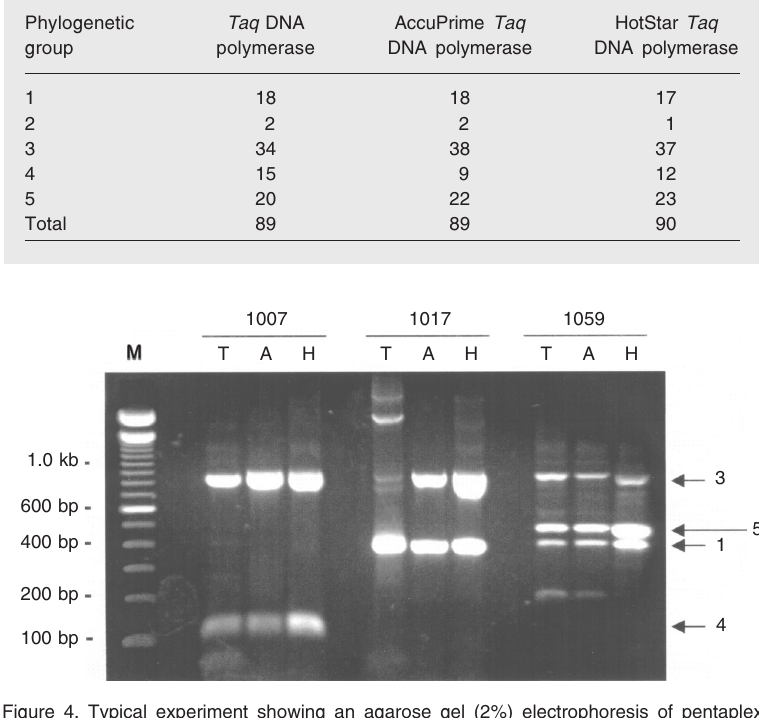
Figure 4. Typical experiment showing an agarose gel (2%) electrophoresis of pentaplex PCR products derived from three serum samples (1007, 1017, and 1059). Amplification was performed with the conventional Taq DNA polymerase (T), AccuPrime Taq DNA polymer- ase (A) and HotStar Taq DNA polymerase (H). Numbers on the right side of the gel indicate Torque teno virus phylogenetic groups. M = molecular weight